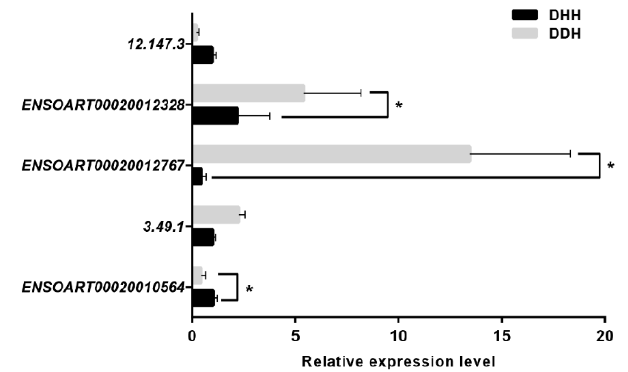
Figure 5. Validation of the differentially expressed isoforms by qRT-PCR; Y-axis denotes isoforms; X-axis denotes isoform relative expression level; DDH denotes Dorper × Dorper × Hu; DHH denotes Dorper × Hu × Hu. Results were presented as the mean ± SEM, * p < 0.05, significant difference.